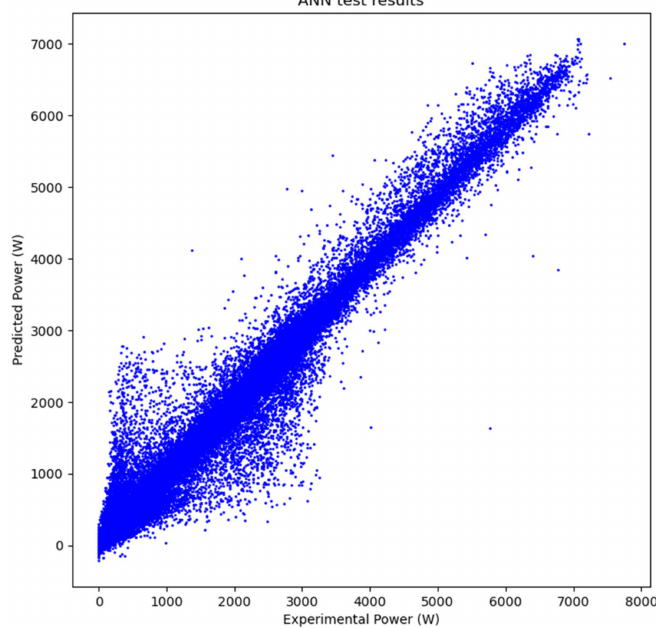
Figure 5. Scatter plot resulting from testing the ANN model.